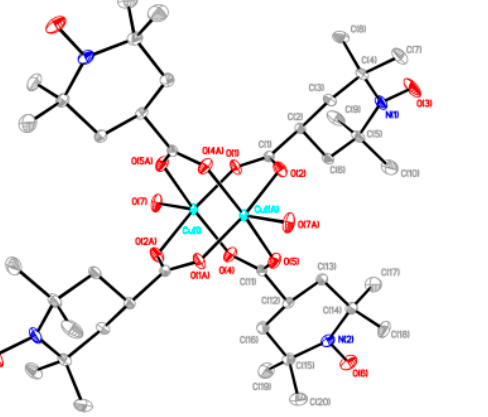
Figure 6. Perspective view of chain molecule for [Cu 2 (caproxy) 4 (pds)] n ( 6 ). Hydrogen atoms are omitted for